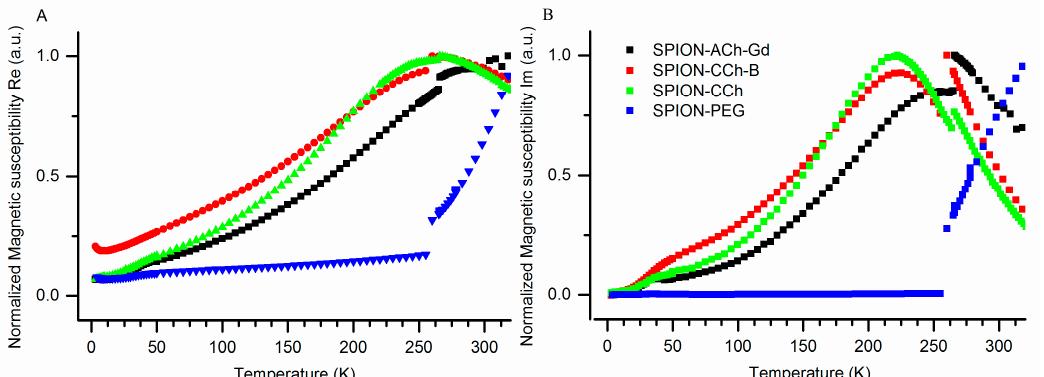
Figure 5. Temperature dependencies of the dispersion part ( A ) and absorption part ( B ) of magnetic susceptibility normalized to their maximum values for aqueous suspensions of the investigated materials measured at 10 kHz.